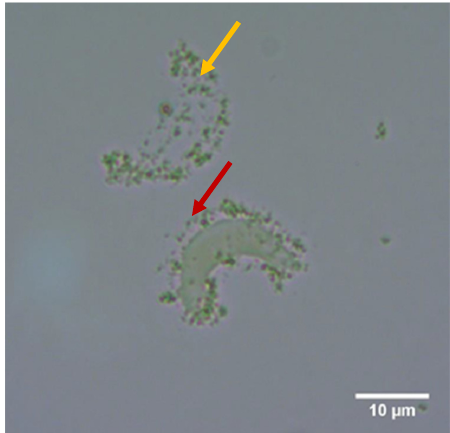
Figure 1. Nanoparticle attachment to transparent, sheath-like structures around algal cells (red arrows). This phase-contrast image (1000× magnification) was captured after 3 h incubation with 100 mg/L CeO 2 NM-212.